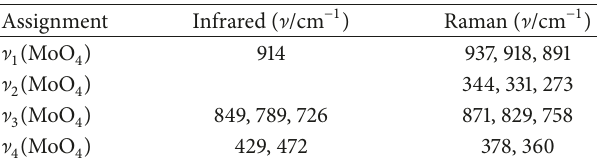
Figure 6: Infrared and Raman spectra of Na 2 K 2 Cu(MoO 4 ) 3 . Table 5: Assignment of the internal vibrational modes frequencies of MoO 4